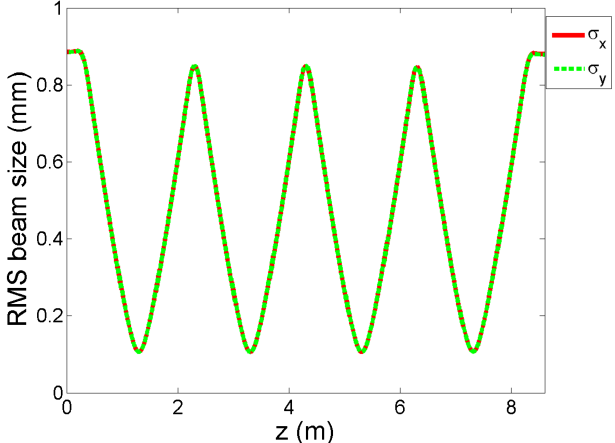
FIG. 5. Evolution of the transverse rms beam sizes in four cells of the PCI lattice of case 1: red — horizontal beam size; green — vertical